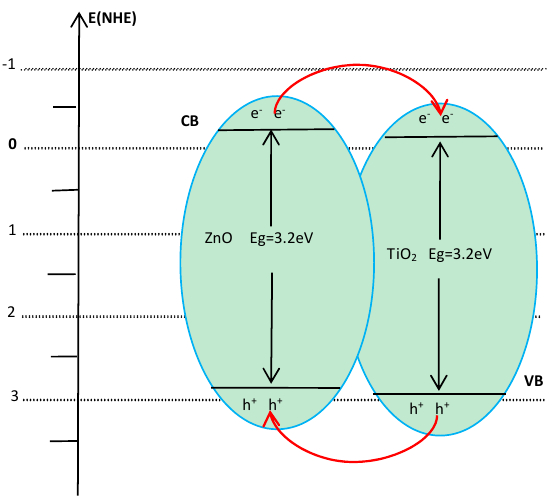
Figure 1. Schematic diagram for charge transfer in composite TiO 2 /ZnO film.